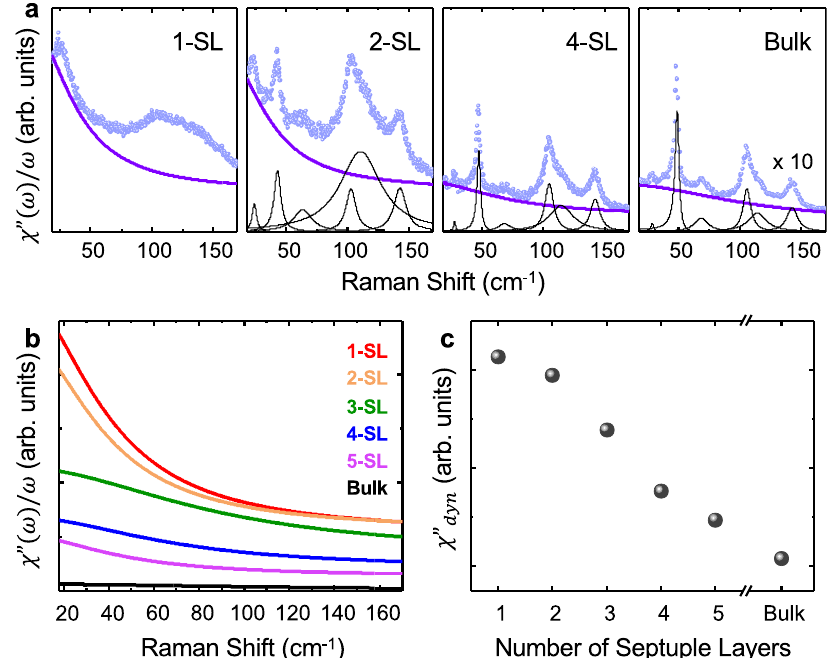
Fig. 4 Magnetic fl uctuations quanti fi ed by the QES peak in the paramagnetic phase at 300 K. a Normalized Raman susceptibility χ ″ / ω for different SLs. The blue dots represent data points. The purple curves are fi ttings given by Eq. (1). Black solid lines are fi tting for several phonon modes using either Lorentzian or Fano functions. b Summary of the fi tted χ ″ / ω for several fl akes with different thicknesses. c Layer-dependent dynamic Raman susceptibility χ 00 χ ″ / ω up to 180 cm − 1 dyn calculated from the integration of